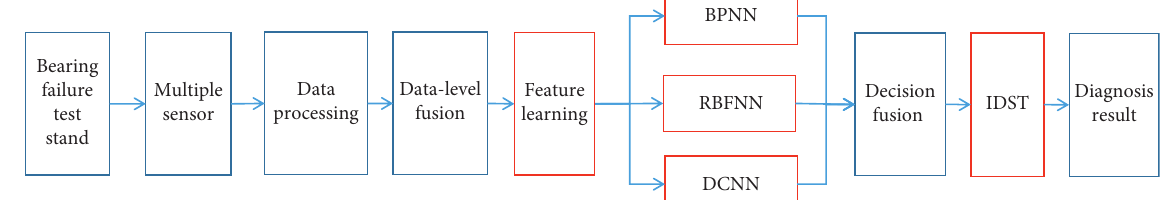
Figure 2: The flowchart based on the DCNN-IDST method.